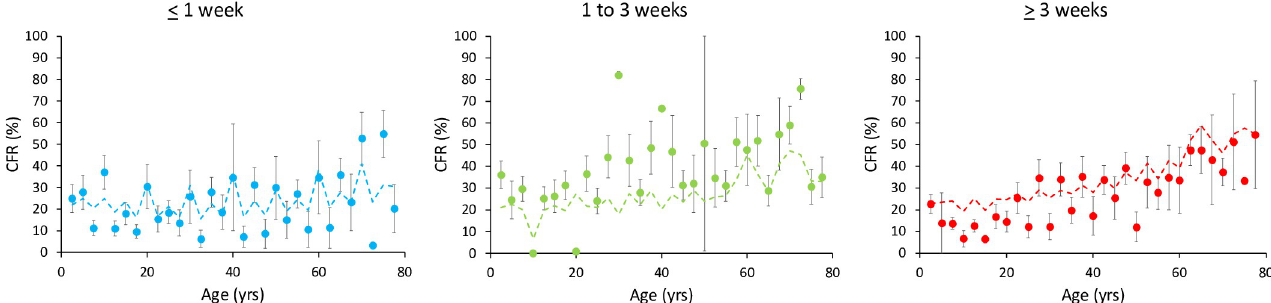
Fig 2. Age-dependent variation in CFR (%) according to the duration of symptoms/illness. Each dot represents the mean CFR for each age class and bars the standard errors. The dotted lines represent the fit of the finite mixture model with a beta-binomial distribution of errors (number of deaths/number of cases).